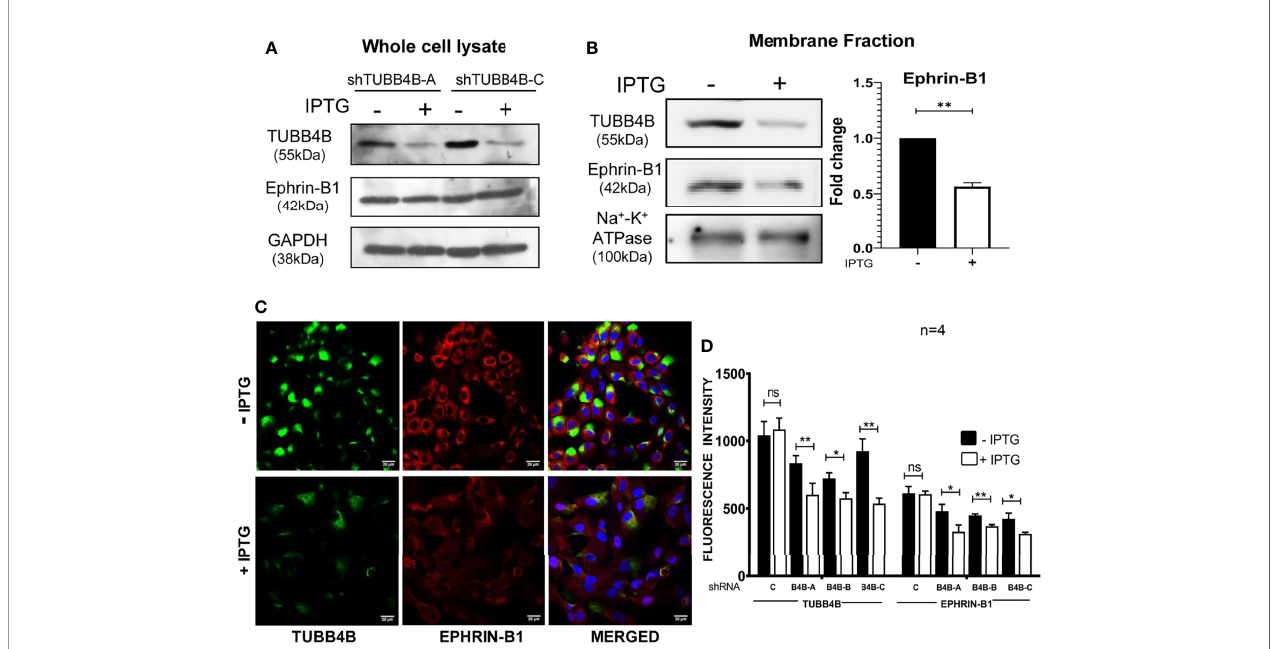
FIGURE 8 | TUBB4B downregulation reduces Ephrin-B1 on the surface. HSC-3 cells stably expressing inducible TUBB4B shRNAs were induced with 50mM IPTG for ten days. Whole-cell lysates (A) and membrane fractions (B) of the TUBB4B shRNA induced and uninduced cells were probed for the indicated proteins by immunoblotting. (C) non-permeabilized TUBB4B shRNA induced and uninduced cells were immune-stained for the indicated proteins. The fl uorescence intensities of TUBB4B and Ephrin-B1 were calculated by drawing ROIs around cells. Average intensities were graphically plotted for induced and uninduced cells of the three lentiviral TUBB4B shRNAs (B4B-A, B4B-B and B4B-C), and non-target shRNA(c). ns represent non-signi fi cant data, (D) * represents p < 0.05, ** represents p < 0.01. Scale bar represents 20 m